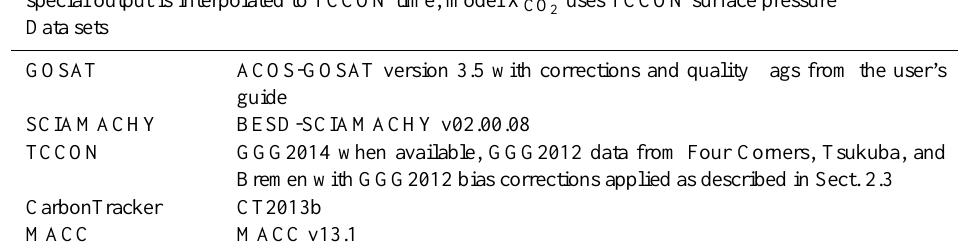
Table A1. Coincidence criteria, data versions, and terminology used in our analysis. Coincidence criteria Geometric 5 ◦ in lat./long., ± 1h Dynamical from Wunch et al. (2011b); considers free-tropospheric temperature, ± 10 ◦ lat, ± 30 ◦ long. and 5 days (see Sect.